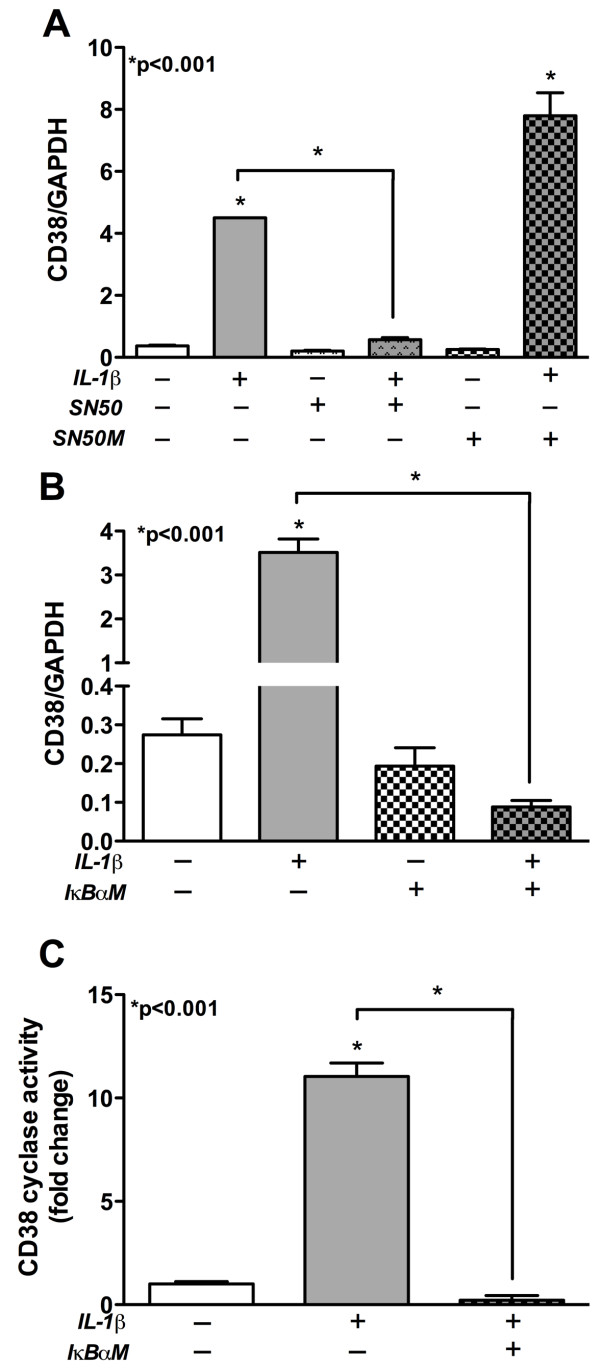
NF-κB regulates CD38 in IL-1β-activated astrocytes. Cultured human astrocytes were activated with and without IL-1β in the presence or absence of NF-κB inhibitors, SN50 or IκBαM. CD38 mRNA expression was measured using real-time PCR while CD38 activity was measured using cADPR cyclase assay. (A) Pre-treatment of IL-1β-activated astrocytes with NF-κB blocker, SN50, showed significantly lower CD38 mRNA levels as compared to IL-1β-activated astrocytes (p < 0.001). SN50M treatment, however, did not affect IL-1β-responses in astrocytes. (B) IκBαM-transfection abrogated the IL-1β-mediated increase in CD38 mRNA levels (p < 0.001) without affecting basal CD38 levels in untreated astrocytes (p > 0.05). (C) IκBαM-transfected, IL-1β-activated astrocytes showed a significant reduction (p < 0.001) in CD38 cyclase activity compared to mock-transfected, IL-1β-activated astrocytes.